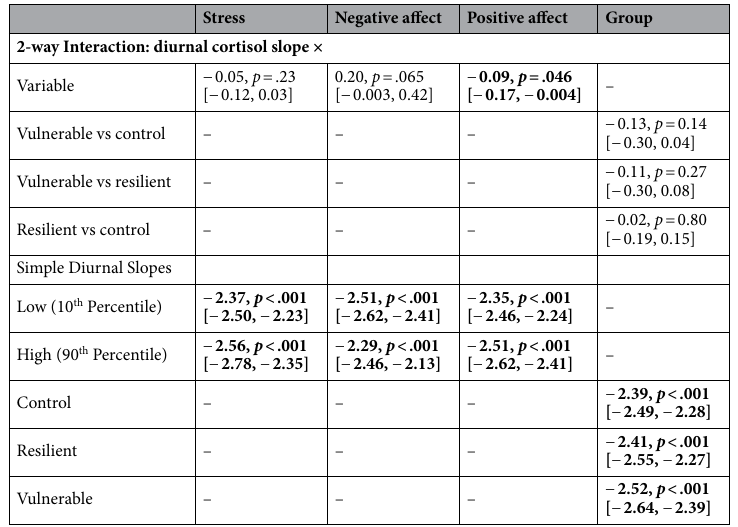
Table 2. 2-Way diurnal cortisol slope × stress/affect/group interactions and simple slopes. Bold highlights p < .05. Estimates are unstandardized regression coefficients for interactions or simple slopes, followed by p -values, and 95% confidence intervals. All estimates are from linear mixed models with all covariates